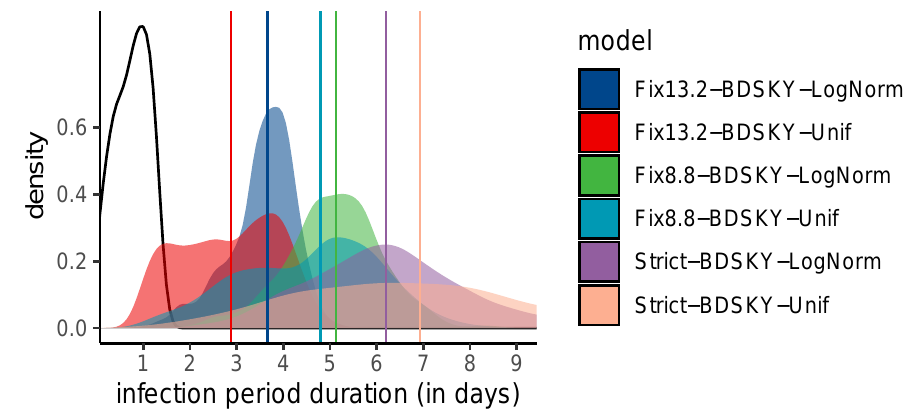
Figure S8 – Effect of the prior shape and of the molecular clock on the effective infection duration estimate. The molecular clock value has a stronger effect than the prior shape. The thick black line shows the prior distribution. Note that the posterior distributions are not very informative, i.e. the 95% HPD is very large, when the molecular clock value is estimated (the ‘Strict’ model).